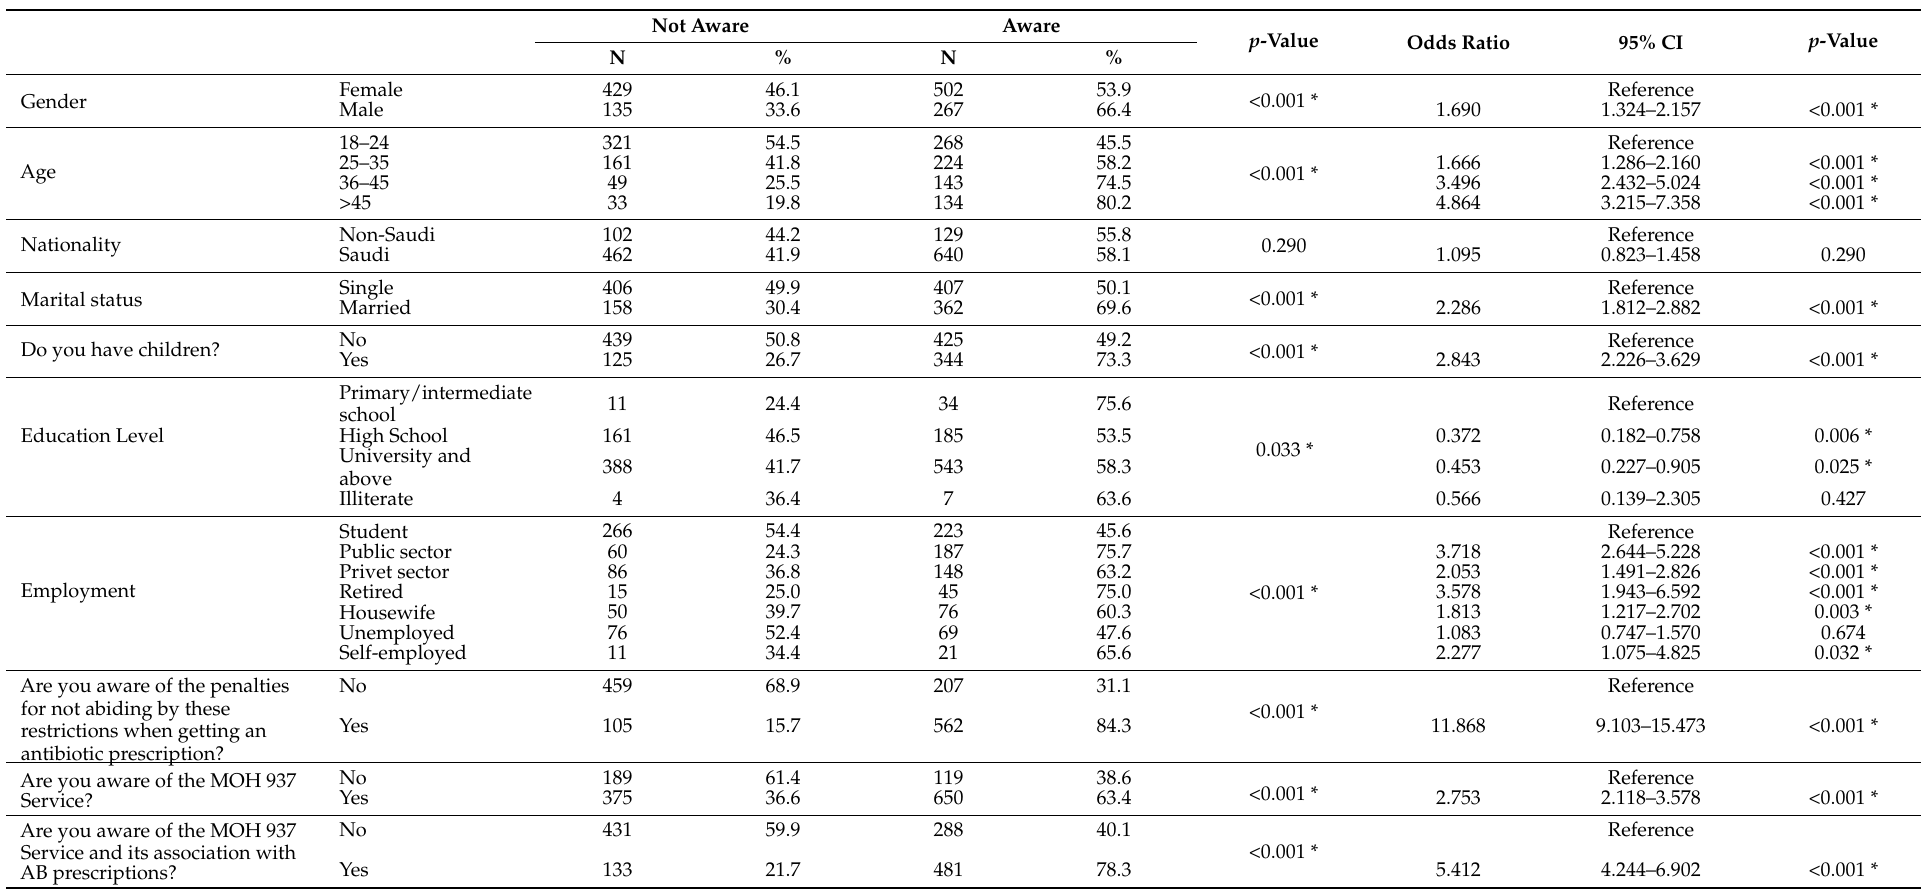
Table 2. Demographic parameters of survey participants stratified by their awareness of the MOH AB restrictions and an awareness assessment using bivariate analysis and odds ratios calculated via binary logistic